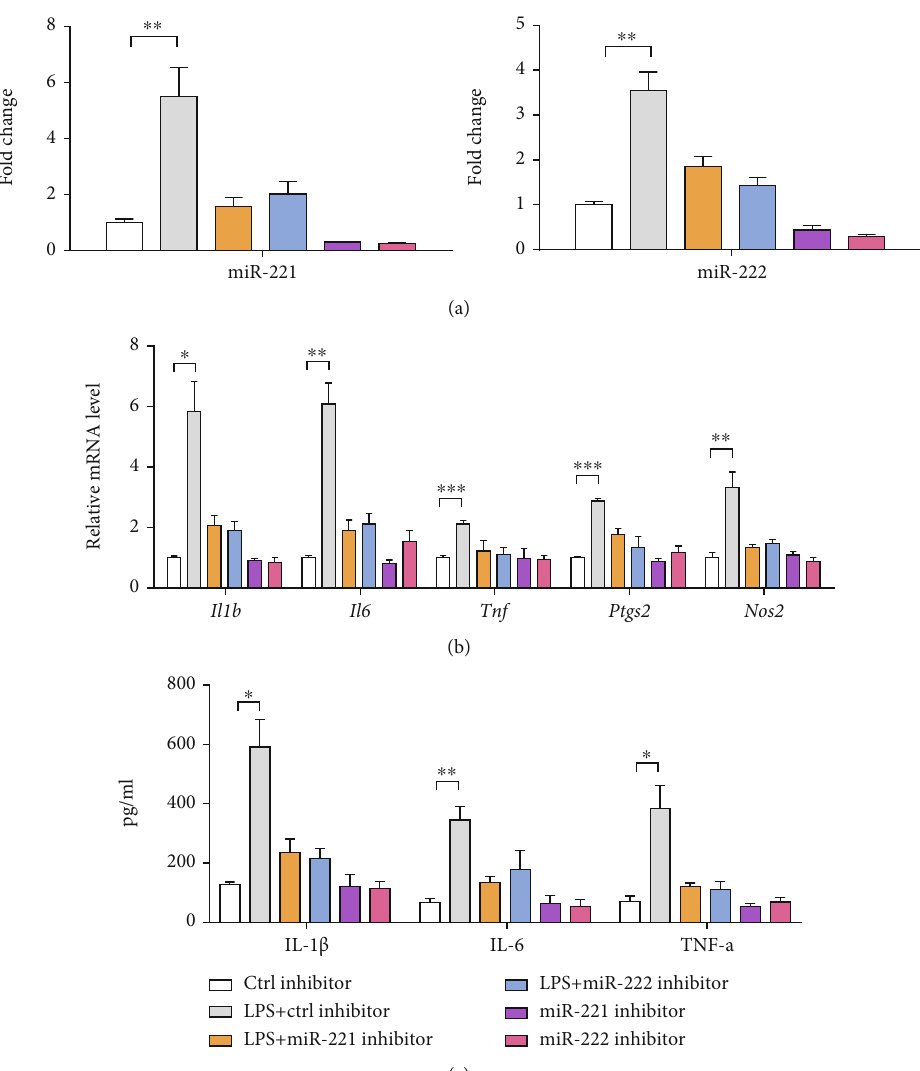
Figure 3: Inhibition of miR-221/222 blocks LPS-mediated BV2 activation. (a) The transfection e ffi ciency of miR-221 and miR-222 inhibitors was validated by qRT-PCR analysis. (b) The e ff ects of miR-221 and miR-222 inhibitors on the mRNA expression of in fl ammatory genes ( Il1b , IL6 , Tnf , Ptgs2 , and Nos2 ) in LPS-primed BV2 cells were determined by real-time qPCR analysis ( n = 3 ). (c) The e ff ects of miR-221 and miR- 222 inhibitors on the level of in fl ammatory cytokines (IL-1 β , IL-6, and TNF- α ) in conditioned medium from LPS-primed BV2 cells were analyzed by ELISA ( n = 3 ). ∗ p < 0 : 05 , ∗∗ p < 0 : 01 , and ∗∗∗ p < 0 : 001